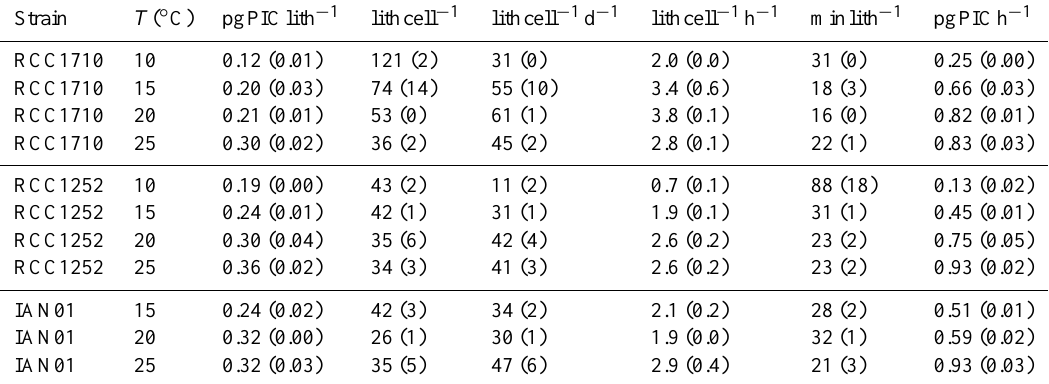
Table 6. Coccolith production time. Standard deviation of the triplicates is shown in parentheses. Lith: coccolith; d: day; h: hour; min: minutes. Strain T ( ◦